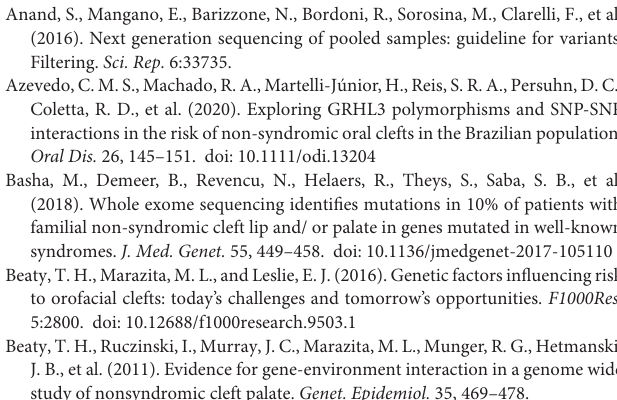
Supplementary Figure 1 | Protein-protein interaction networks constructed with the previously syndromic cleft palate only (SCPO)-associated genes identified in the pools of patients with non-syndromic cleft palate only (NSCPO), but not in the control, using STRING. The networks include 205 edges (interactions) among 98 nodes based on curated databases (light blue), experimentally (purple), gene neighborhood (green), gene fusions (red), gene co-occurrence (blue), textmining (light green), co-expression (black) and protein homology (violet). The overall confidence score of this analysis was 0.446 ( P < 1.0e-16), indicating a low change for false-positive interactions. Supplementary Figure 2 | The protein-protein interaction networks with cleft lip-palate (CLP)-associated targets found in the pools of patients with non-syndromic cleft palate only (NSCPO), but not in the control. Networks include 244 interactions among 91 nodes (overall coefficient score = 0.557; P < 1.0e-16). Different colors represent different levels of evidence of connection between proteins. Light blue represents curated databases, purple experimental evidence, green gene neighborhood, red gene fusions, blue gene co-occurrence, light green evidence from textmining, black co-expression, and violet protein